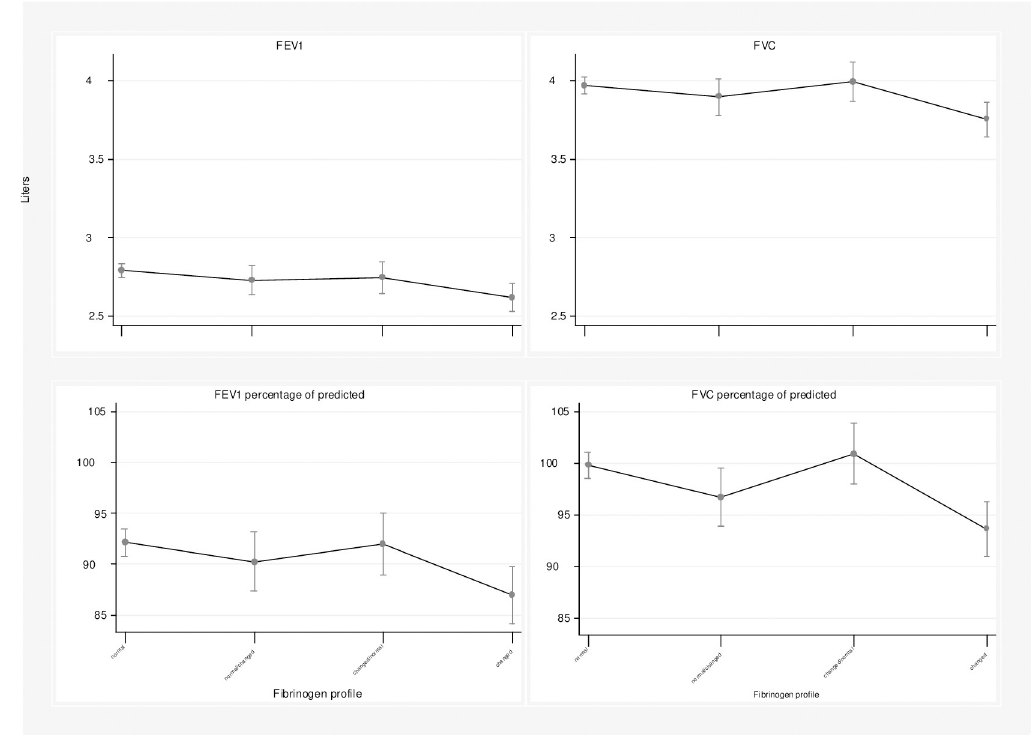
Fig 2. Linear predictions for the FEV 1 (L), FVC (L), FEV 1 percent predicted and FVC percent predicted in men, The English Longitudinal Study of Ageing, England, 2004 to